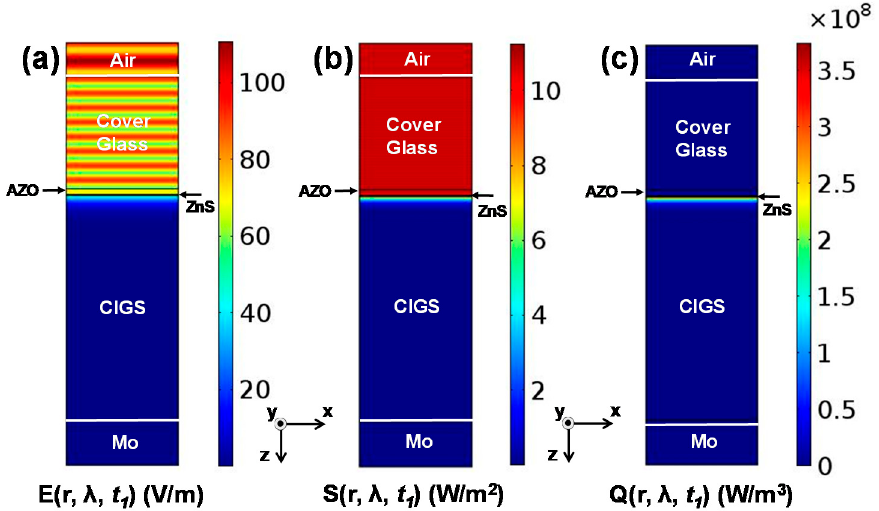
Figure 3. Calculated 2D spatial profiles of ( a ) the electric field amplitude, ( b ) time-averaged Poynting vector and ( c ) optical power dissipation at a wavelength of λ = 400 nm. The equispaced phase thickness of the EPL was set to t 1 = 0 nm.